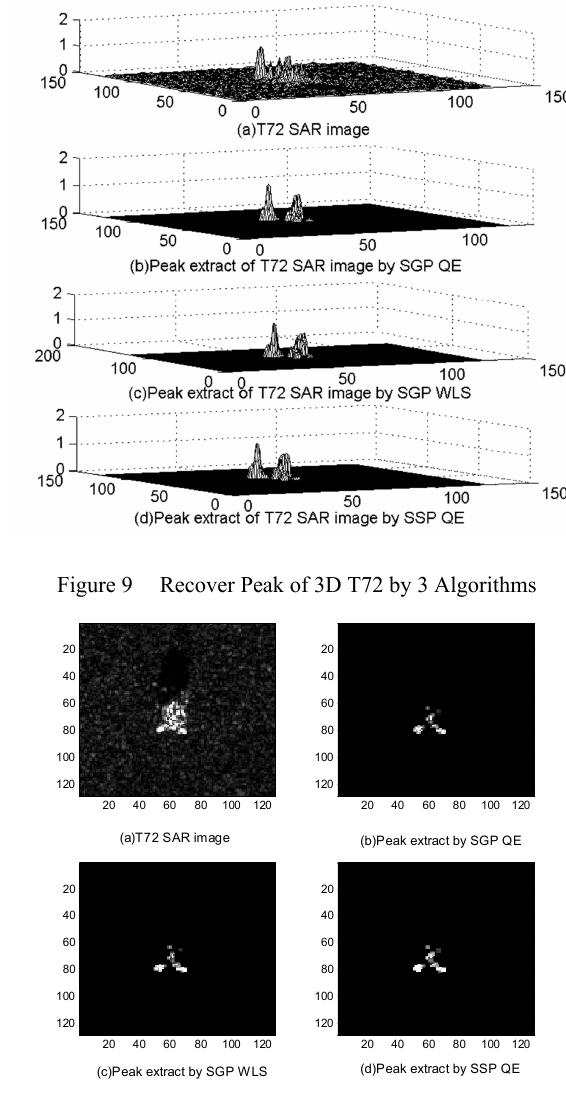
Figure 10 Recover Peak of 2D T72 by 3